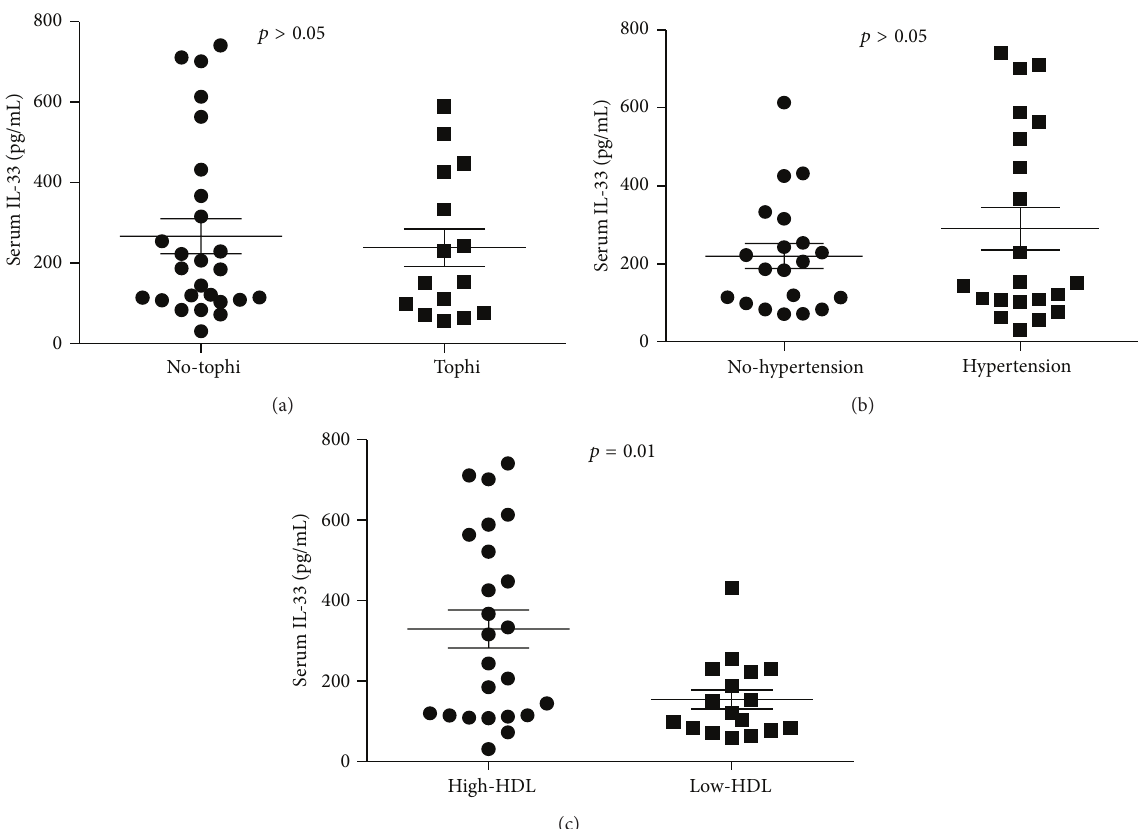
Figure 2: Difference of IL-33 expression in gout patients with tophi, hypertension, and HDL. The renal function was affected by tophi, hyperlipoidemia, and hypertension in gout patients. The serum levels of IL-33 in patients were grouped according to tophi, hypertension, and HDL. These groups were evaluated by Mann-Whitney 𝑈